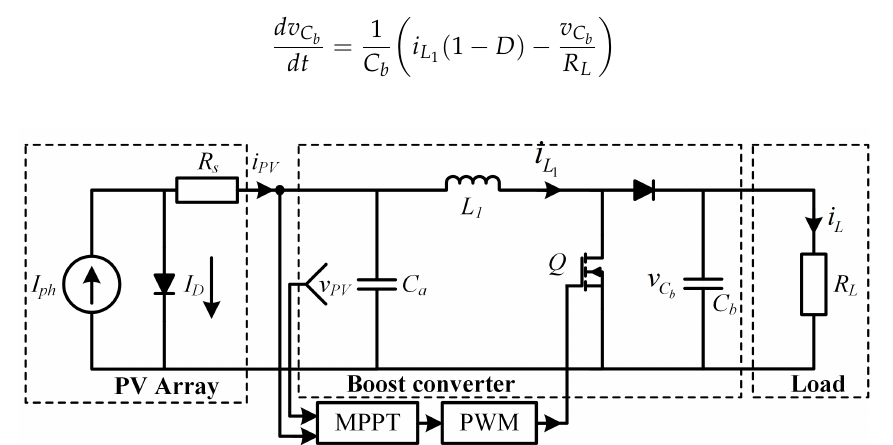
Figure 1. Photovoltaic energy